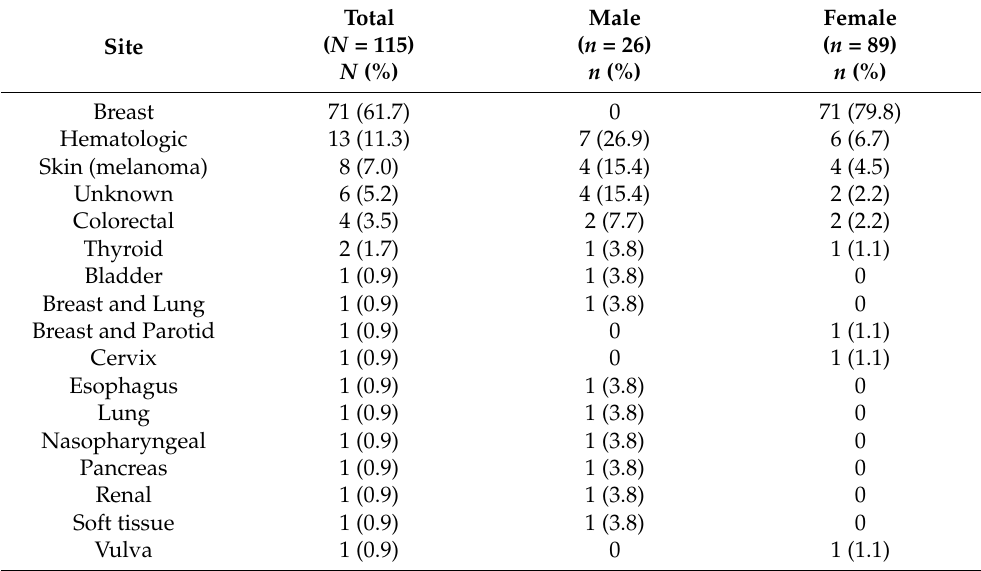
Table 1. Site of location of primary cancer and sex distribution.